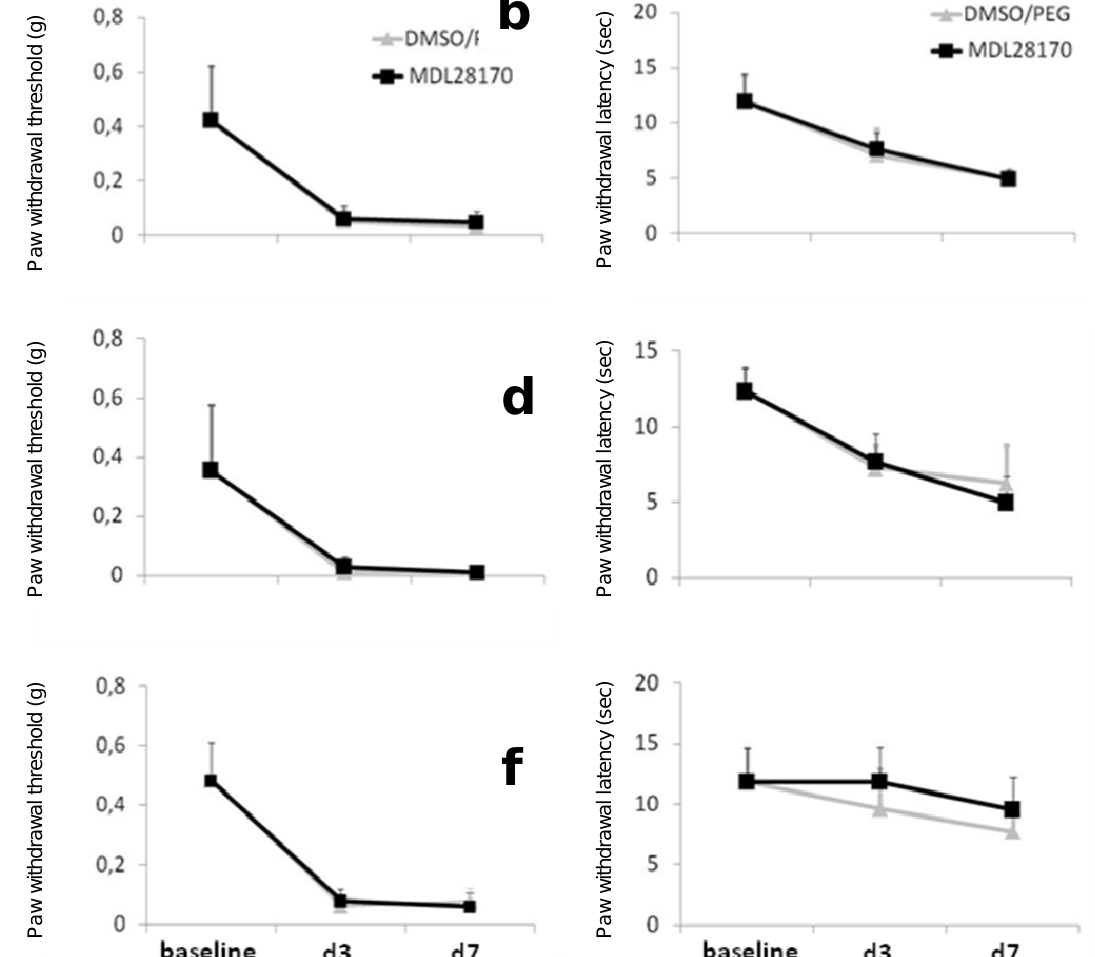
Figure 2. Paw withdrawal thresholds to mechanical stimuli (a, c, e) and paw withdrawal latencies to thermal stimuli (b, d, f) in mice after chronic constriction injury (CCI) and different application regimes of